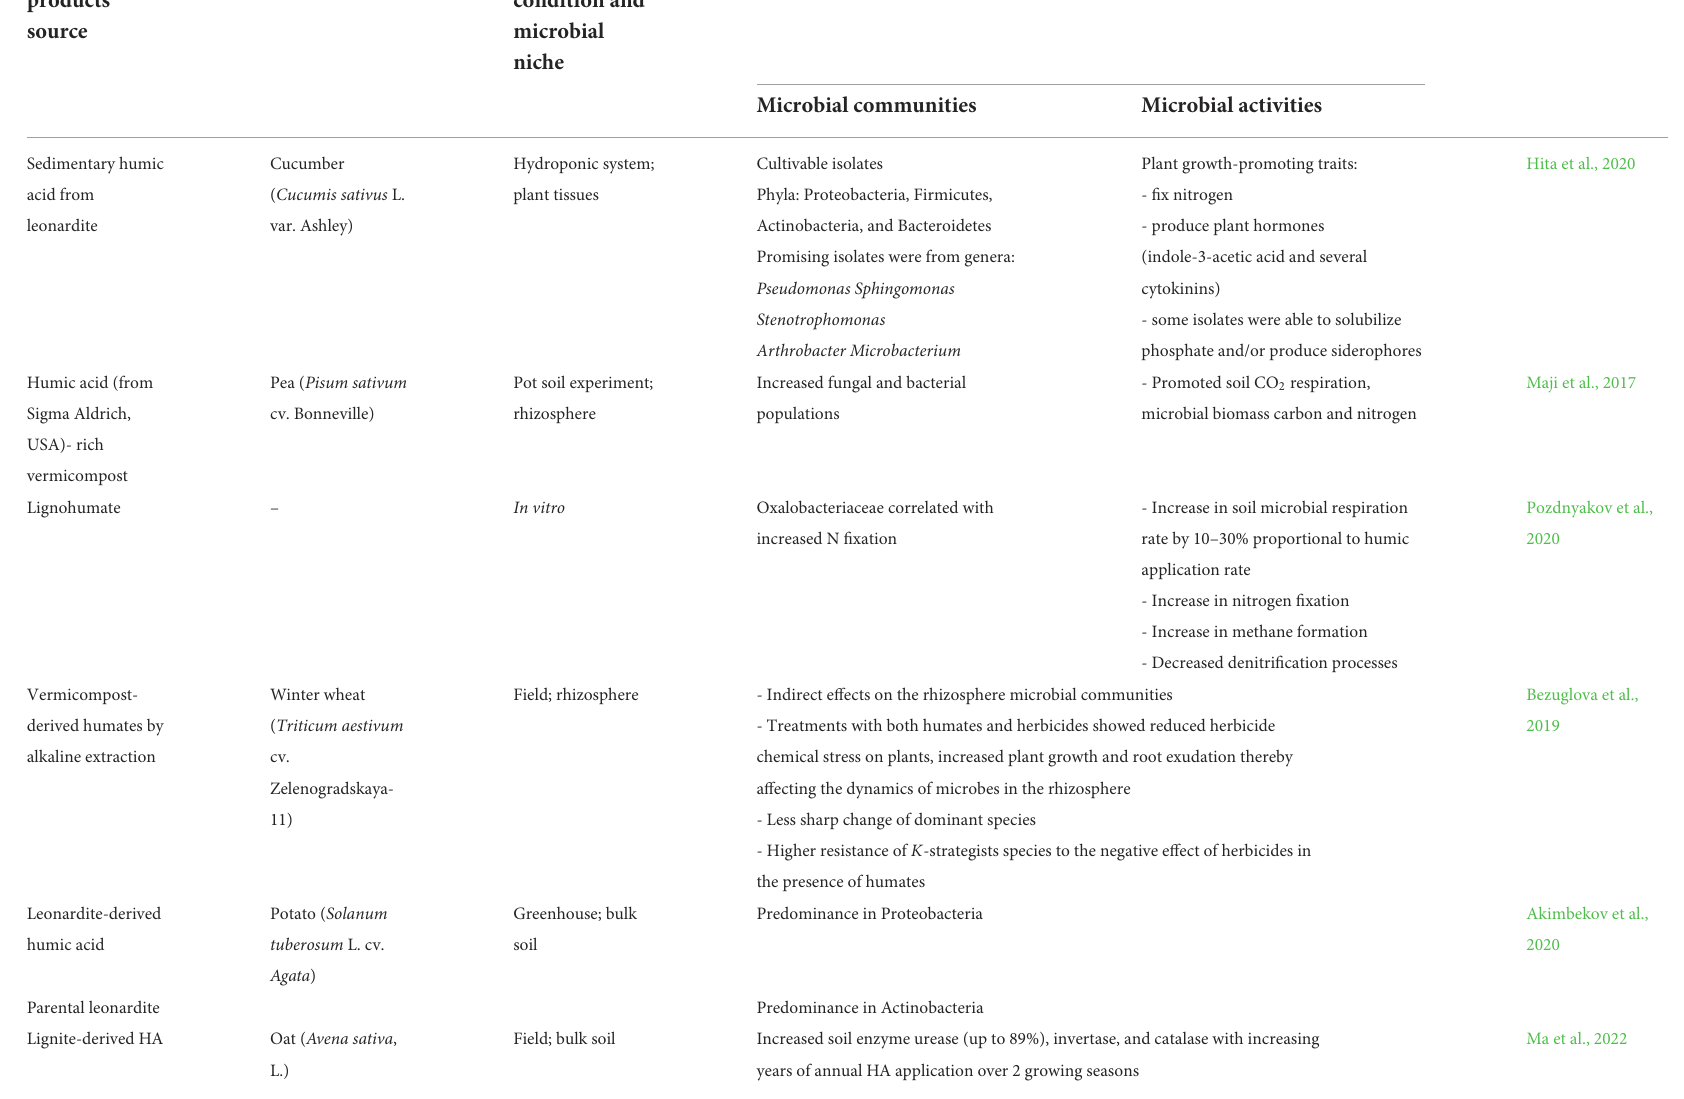
TABLE 1 The effects of humic-based products on microbial communities and